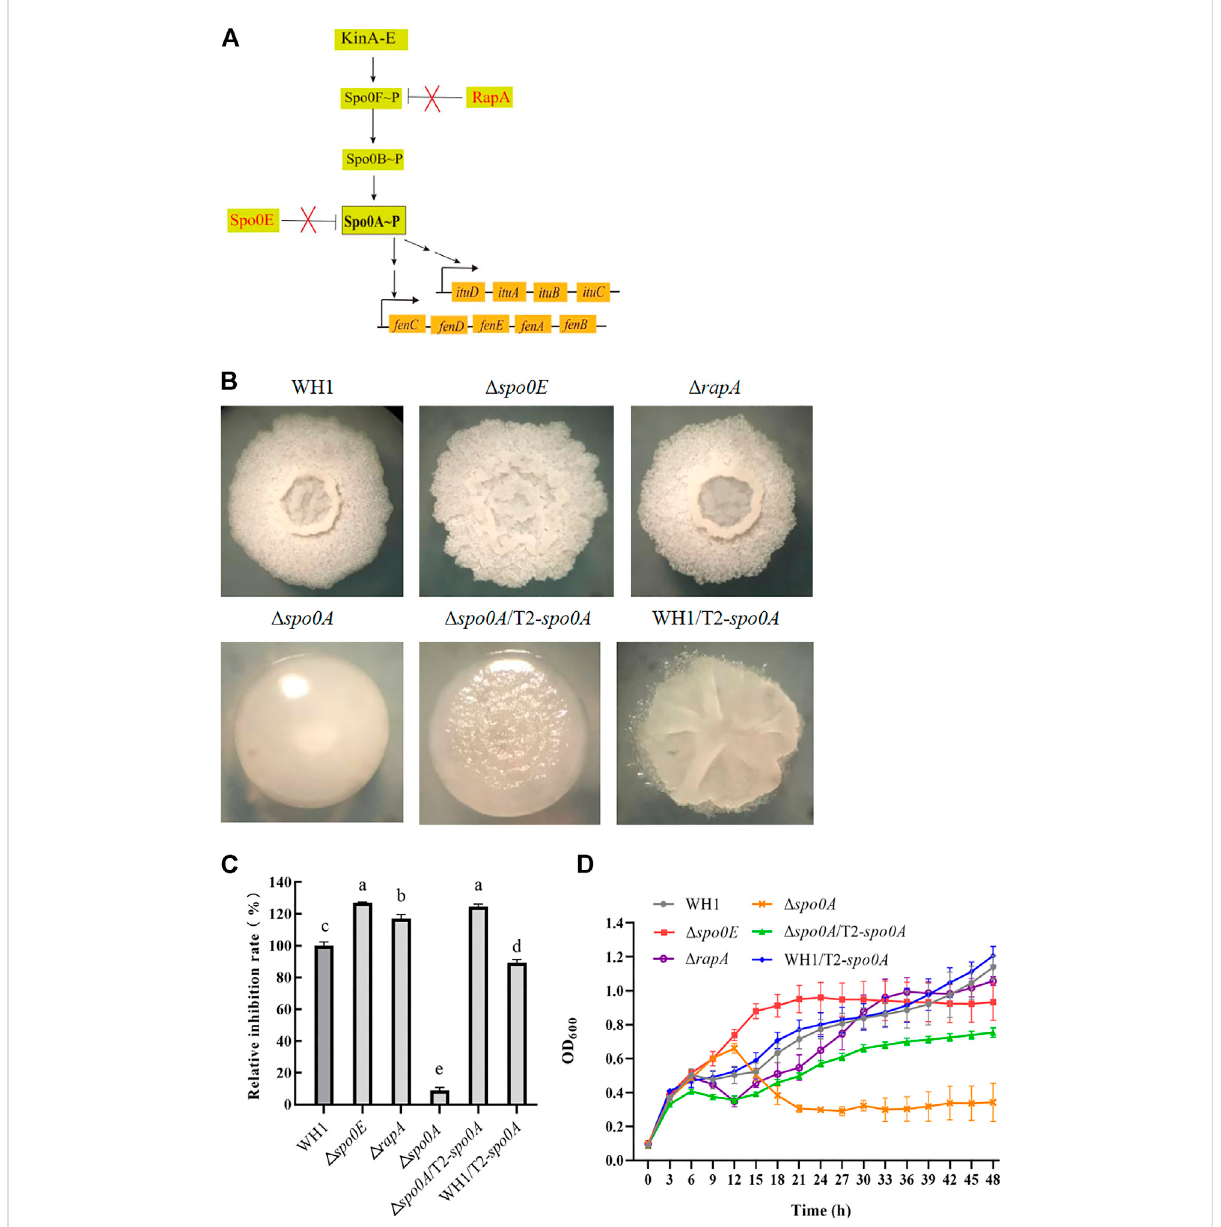
FIGURE 7 Relative inhibition rates and characteristics of engineered strains related with Spo0A phosphorylation. (A) : Phosphorylation and dephosphorylation of Spo0A. Spo0F and Spo0B are the phosphate group transporters. (B) : Colony morphology. (C) : Relative inhibition rates. (D) : Growth